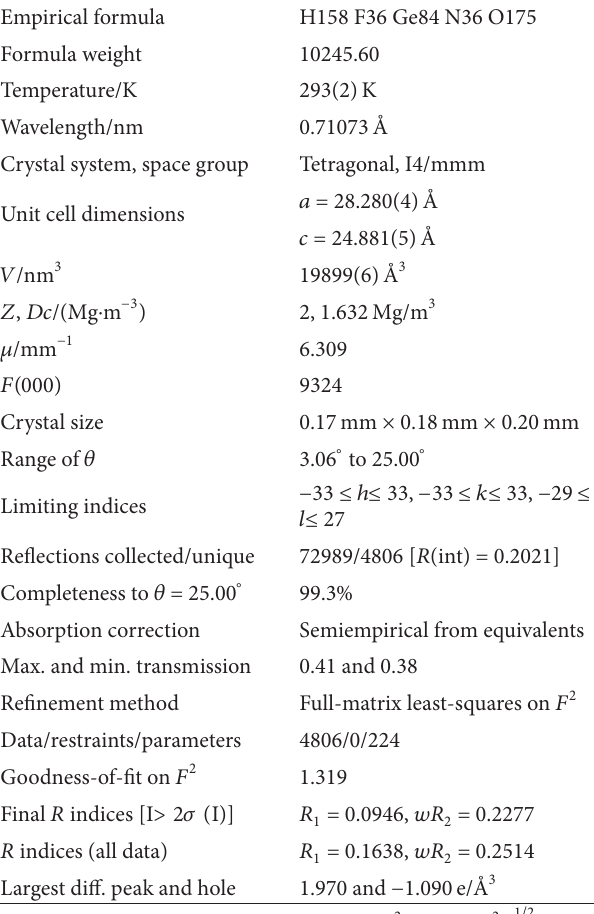
T 1: e crystallographic data and structural re�nement for